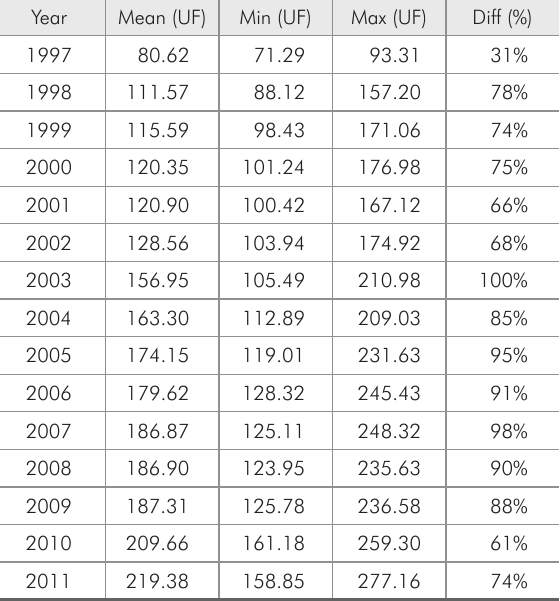
Figure 3 - Admission cutoff score (PAA / PSU) and percentile rank over the entire university system for entry into dentistry in Chile,